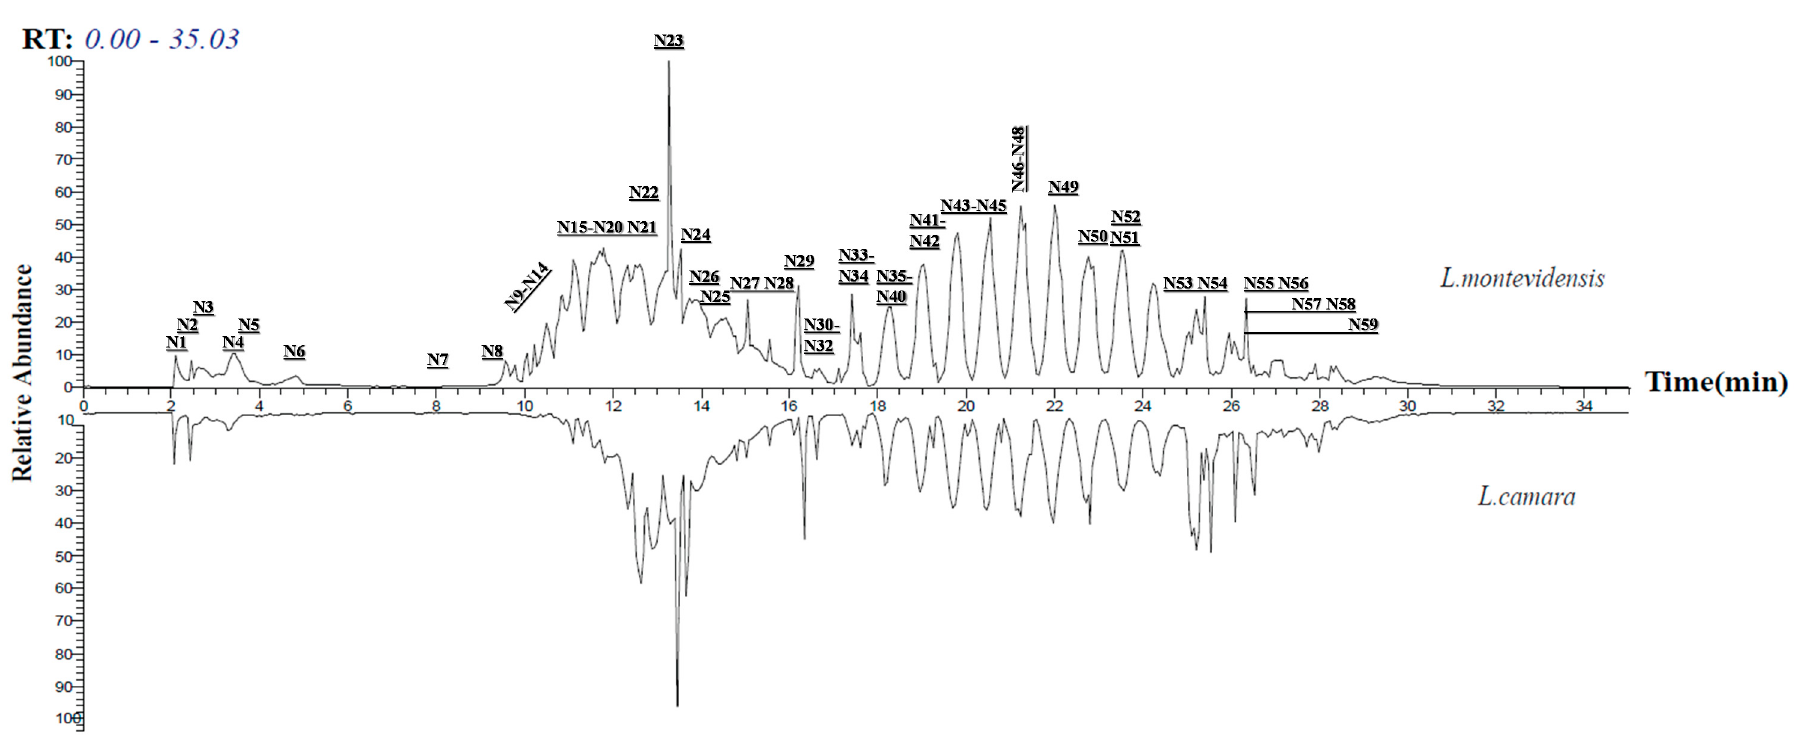
Figure 1 . LC-MS chromatograms of L. montevidensis and L. camara in the positive ion mode prescribing the annotated metabolites from N1–N59 as exhibited in Table 1. Table 1. LC–LTQ–MS–MS dereplication of the alcoholic leaf extracts of L. camara ( Lc ) and L. montevidensis ( Lm ) crude